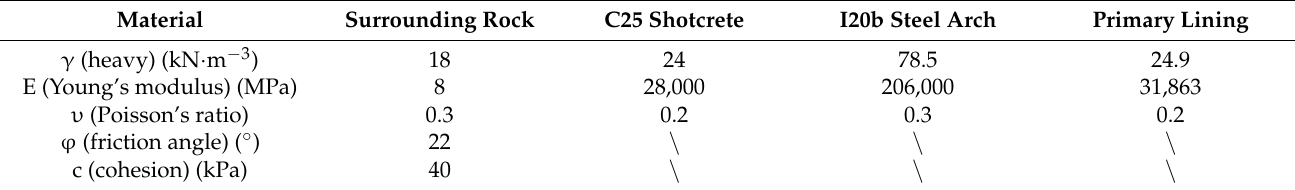
Figure 7. Finite element local model. Table 2. Model calculation